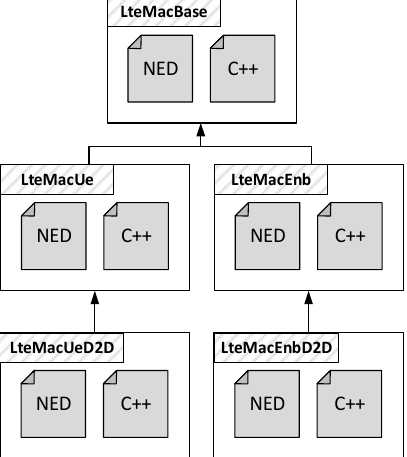
Figure 9. Example of inheritance of NED structure and C++ class for D2D-specific modules.